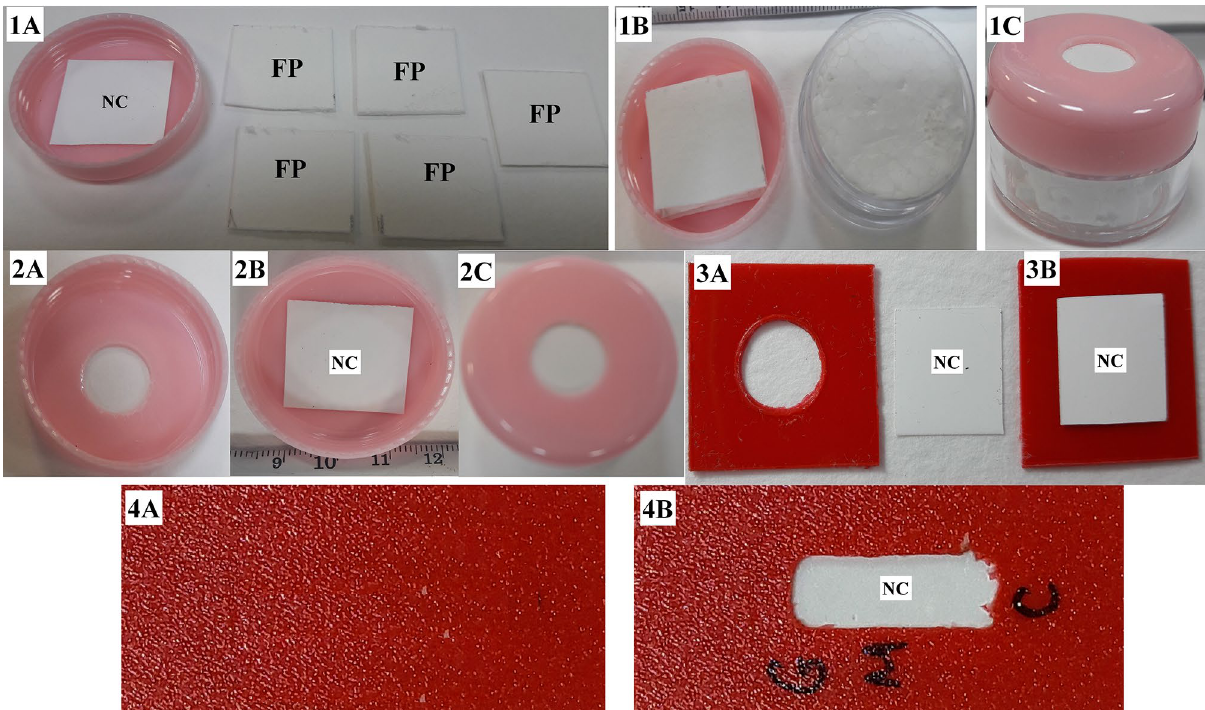
Figure 6. Components of TLTD. Format 1 (1A-1C); Format 2 (2A-2C); Format 3 (3A-3B) and Format 4 (4A- 4B). Where NC: Nitrocellulose membrane covering the plastic opening; FP: absorbing filter papers. Format 1 is formed of a cap with a circular opening, a nitrocellulose membrane put into the inside of this cap to cover its opening (1A), FP put over the NC (1B), and the cap containing the NC and FP are put on the container body to get the final shape of the TLTD format 1 (1C). Format 2 is formed of only a cap (2A) and a NC (2B) affixed with a tape into the inside of the cap to cover its opening (2C). Format 3 is formed of only a square piece of plastic with circular hole in its center (3A) and a NC affixed with a tape to into one side to cover its opening (3B). Format 4 is formed of only a rectangular piece of plastic (4A) with a centered rectangular opening and a NC affixed with a tape at one side to cover its opening (4B).